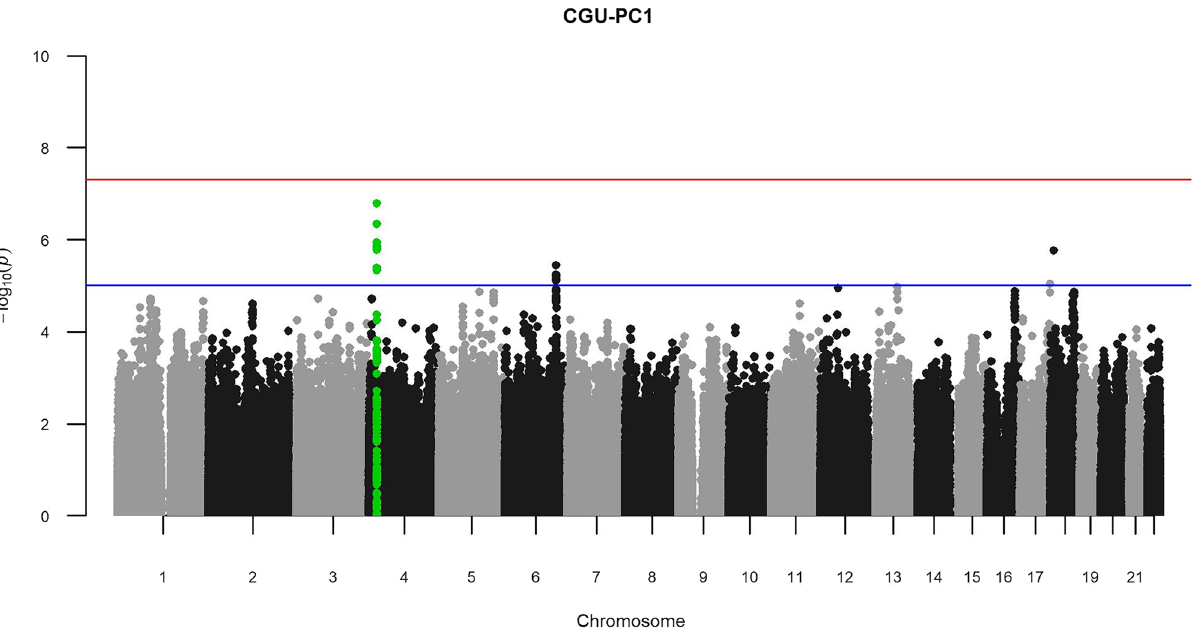
Figure 2. Manhattan plot for CGU-PC1 extracted from the 3 CKD primary traits. The red line indicates genome-wide significance threshold of 5 × 10 −8 , while the blue line indicates the suggestive threshold of 1 × 10 −5 . CGU—serum creatinine, eGFR, and serum urea.